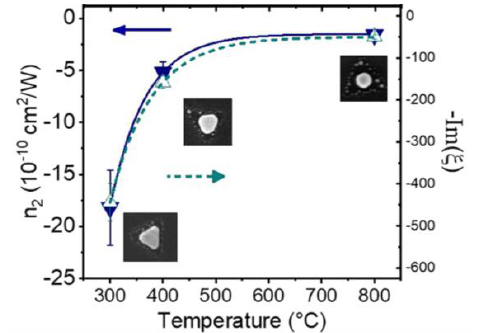
Fig. 2. Nonlinear refractive index n 2 (blue triangles, left-hand scale) of Au HNPA as a function of the annealing temperature. Open symbols (right-hand scale): imaginary component of the integrated local-field distribution in the nanoarray.